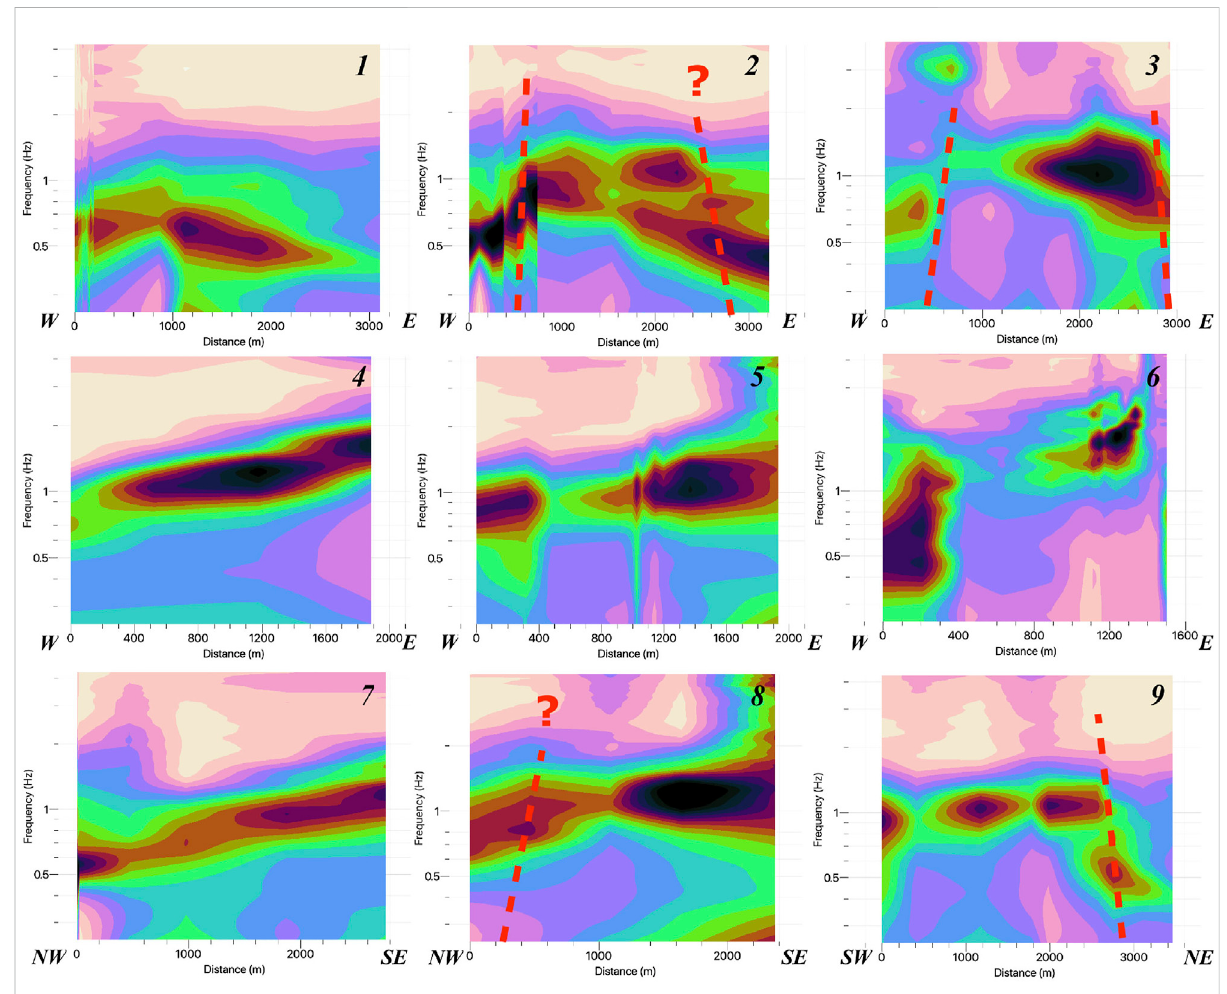
FIGURE 5 HVNSR contour plots of investigations organized along the transects. The plots correspond to sections 1 – 9 (see location in Figure